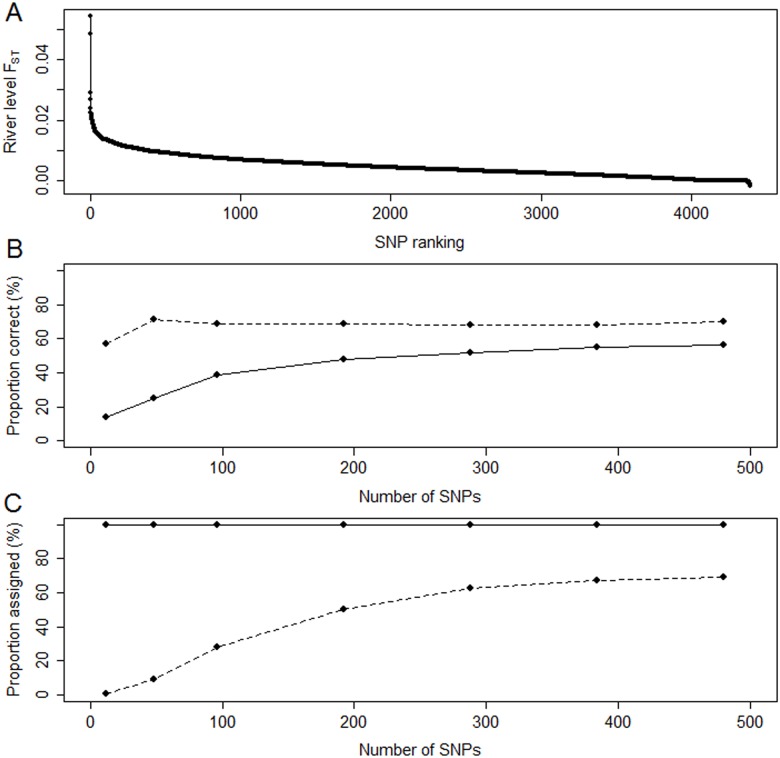
SNP ranking and assignment accuracy to river.A) between-river FST values for the ranked SNPs. B) assignment accuracy of hold-out set fish assigned to training set reference sites using different numbers of the top ranked SNPs. C) proportion of hold-out set fish assigned to training set reference sites using different numbers of the top ranked SNPs. Solid lines represent all fish, dashed lines only those fish with an assignment likelihood score of at least 80.